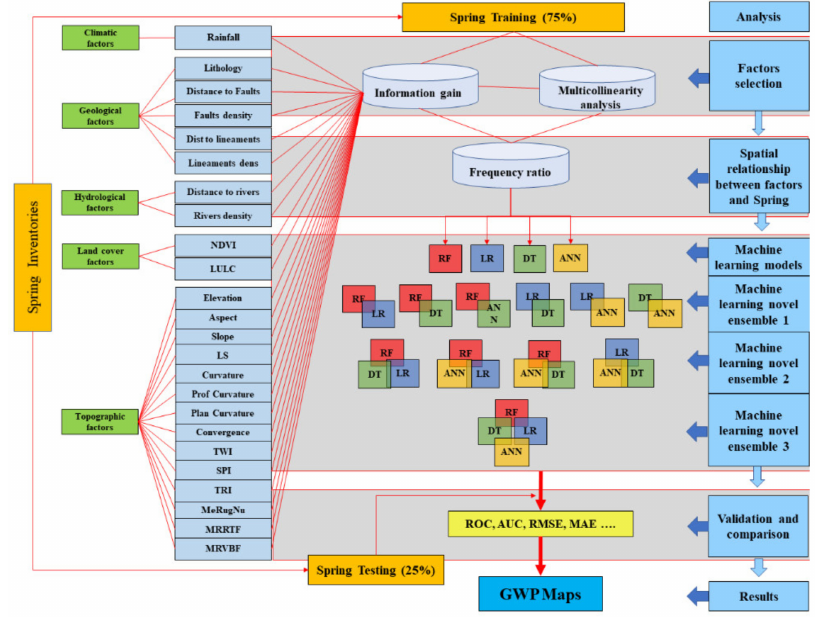
Figure 3. Methodology used in this